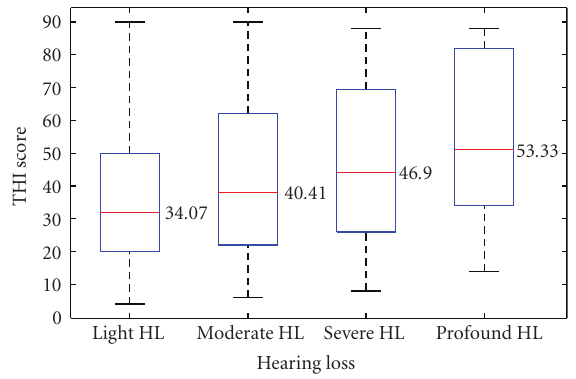
Figure 3: ANOVA test for THI score: Light HL 34 . 07 ± 20 . 09; Moderate HL 40 . 41 ± 22 . 95; Severe HL 46 . 90 ± 24 . 48; Profound HL 53 . 33 ± 30 .